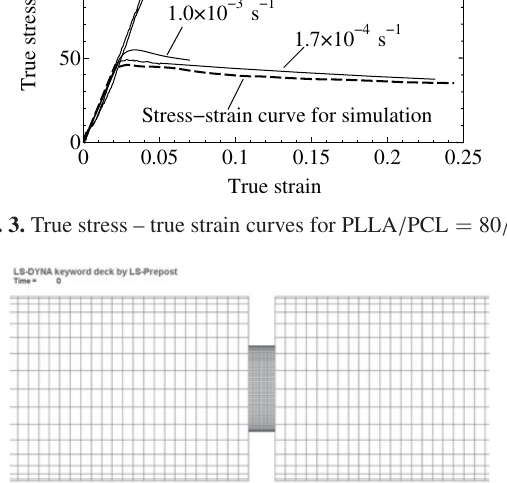
Fig. 1. X-ray computed tomography of specimen.